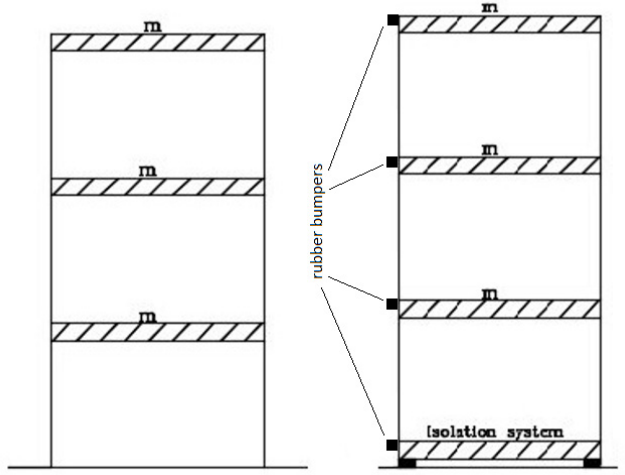
Figure 6. Schematic diagram of two three-story isolated models and the locations of rubber bump ‐ ers.